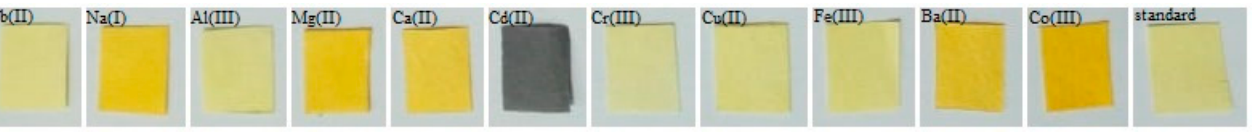
Figure 6. Color change in DCDHFH-immobilized strip for different metal ions (250 ppm) in aqueous medium.